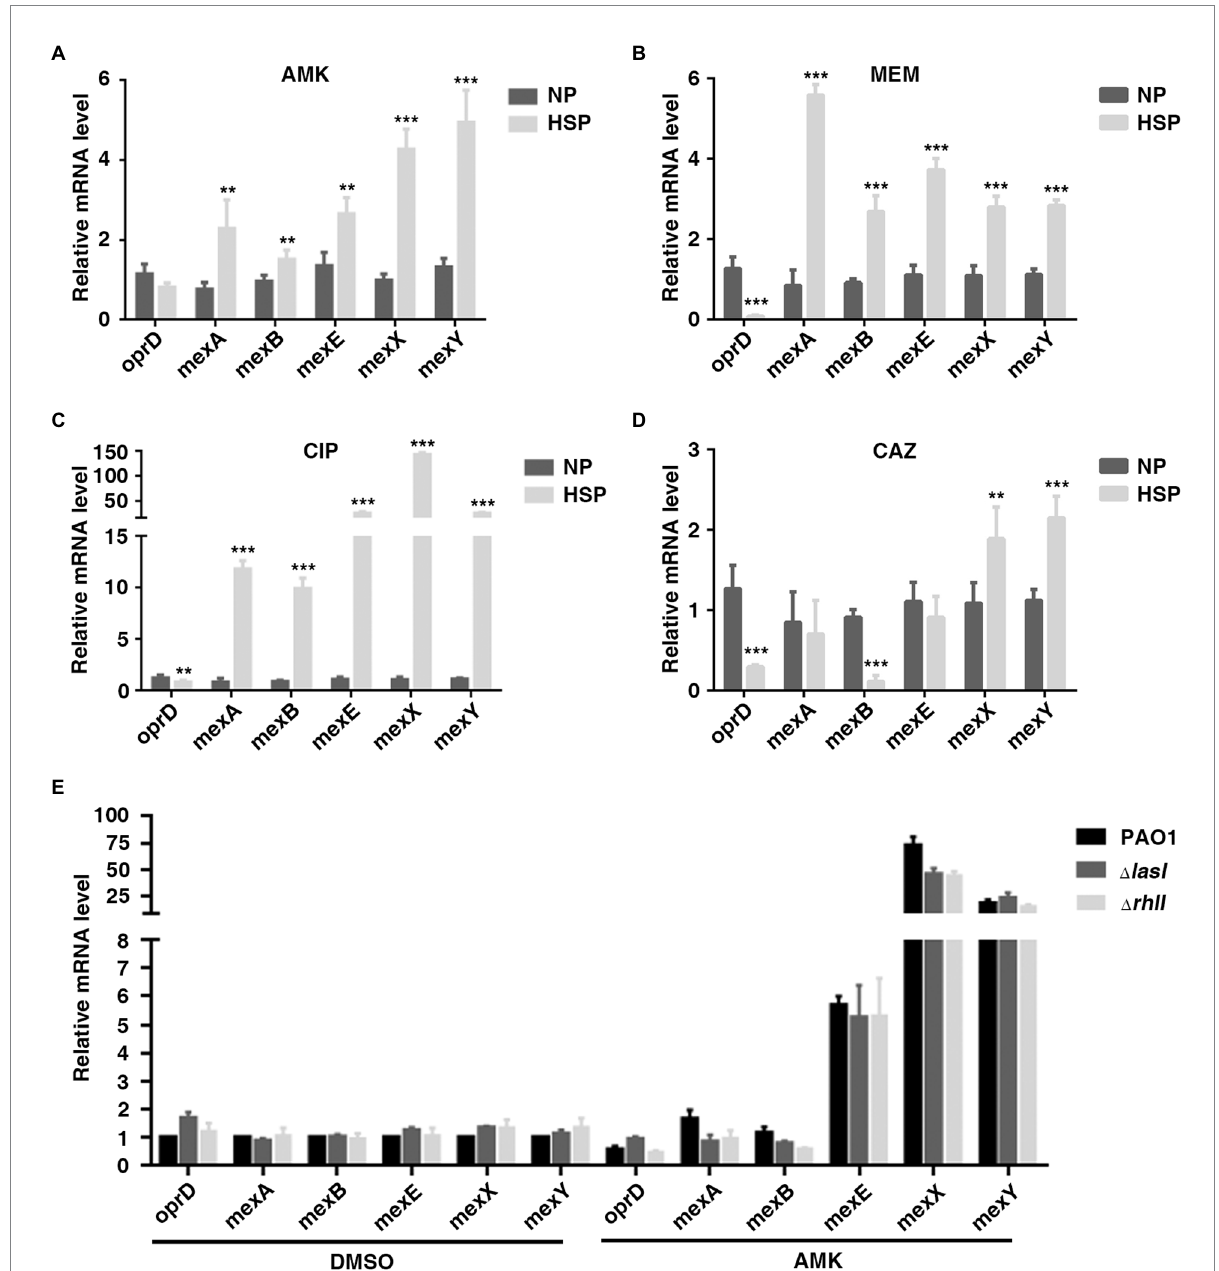
FIGURE 4 OprD and efflux-associated genes were not involved in QS-inhibited HR. (A–D) Expression of OprD and efflux-associated genes in native population (NP) and resistant subpopulation (HSP) of AMK, MEM, CIP, or CAZ. A resistant colony growing on PAPs test plates with highest antibiotic concentration was re-streaked with the same concentration of the indicated antibiotics, followed by real-time PCR analysis. (E) The expression of oprD and efflux-associated genes was not regulated by LasI and RhlI. PAO1, PAO1 Δ lasI , and PAO1 Δ rhlI were cultured in LB for 6 h before qPCR analysis. The rpoD gene was used as an internal control. **, p < 0.01; ***, p <